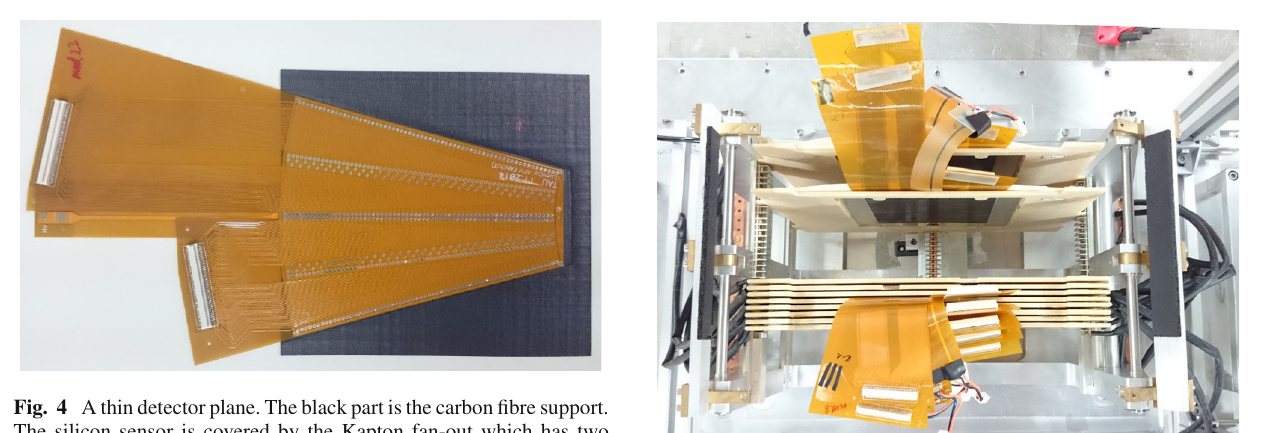
LumiCal, the calorimeter prototype under test. Distances, rounded to integer numbers in centimetres, are shown in the upper part of the